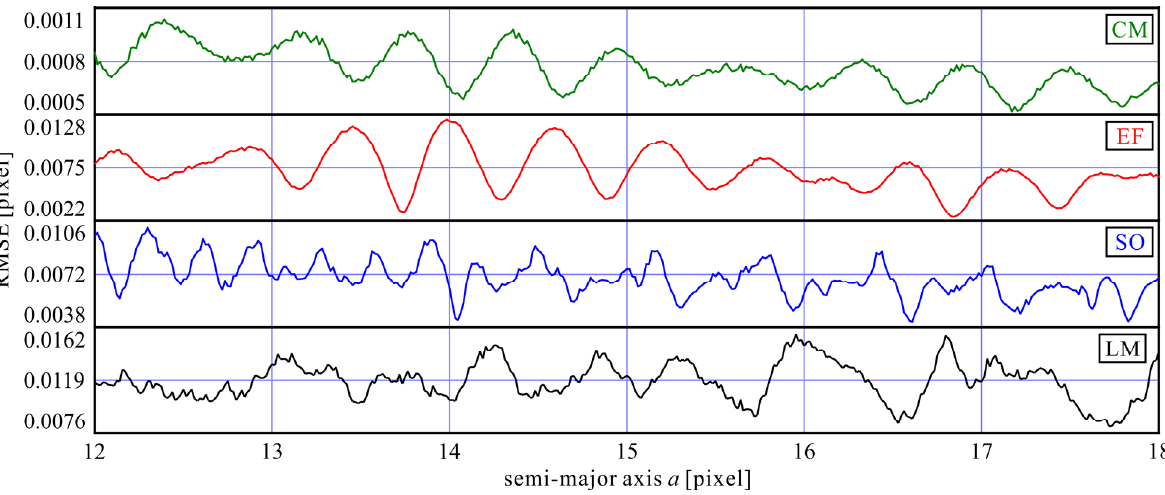
Figure 7. RMSE of the center location measurement of an ellipse (12 pixels  a  18 pixels, f = 0.25,  =22.5º)